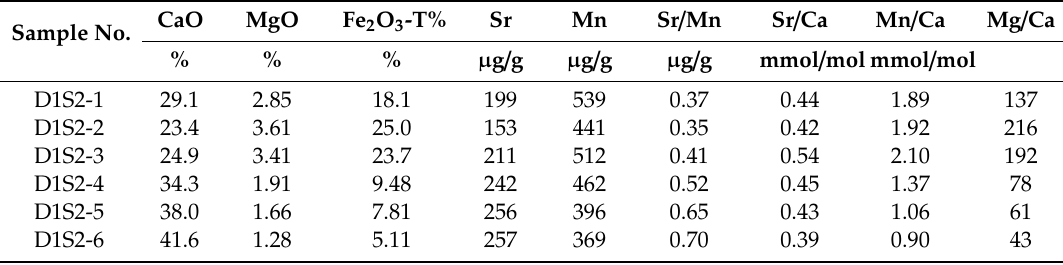
Table 2. Element contents of the studied